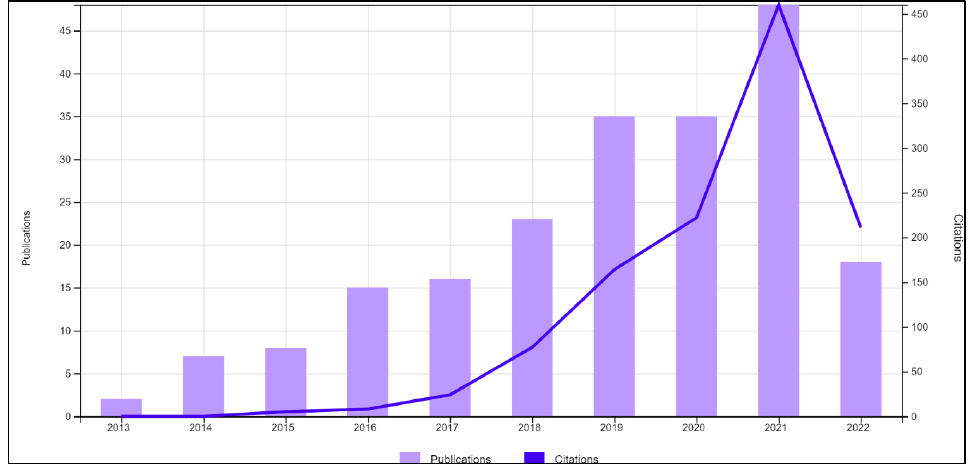
Figure 12. An overview of publications and citations on the topic of Smart cities in Poland. Source: own analysis as per Web of Science (2022).